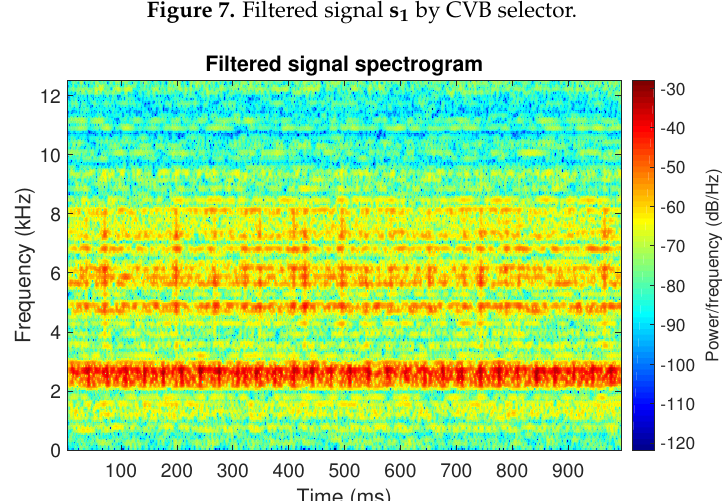
Figure 8. Spectrogram of filtered signal s 1 by Conditional Variance-based (CVB) selector.